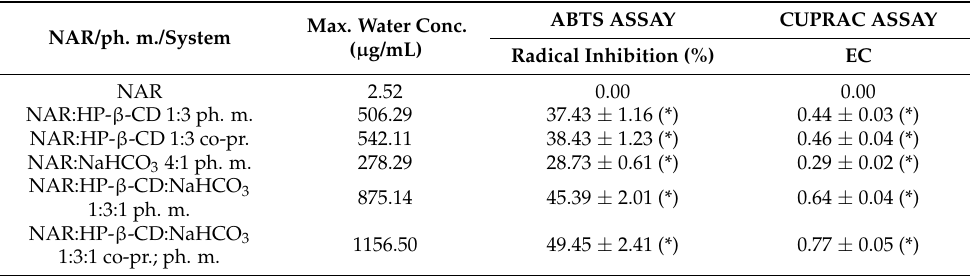
Table 2. Antioxidant activity of NAR, the binary system (NAR:HP- β -CD) obtained by the co- precipitation method, the physical mixtures (NAR:HP- β -CD; NAR:NaHCO 3 ), the ternary system (NAR:HP- β -CD:NaHCO 3 ), and the physical mixture (NAR:HP- β -CD:NaHCO 3 ). (*) indicates statisti- cally significant differences, p <